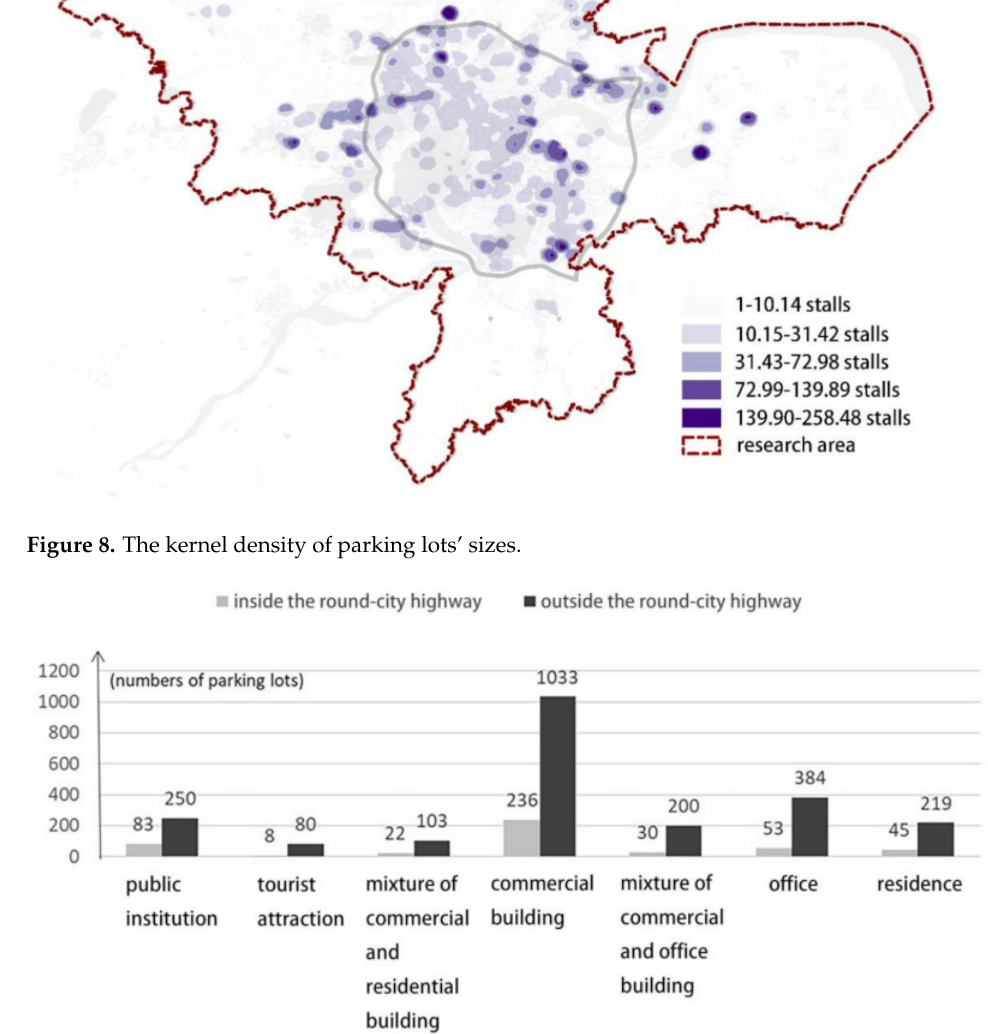
Figure 9. The affiliations of parking lots in and outside the round-city